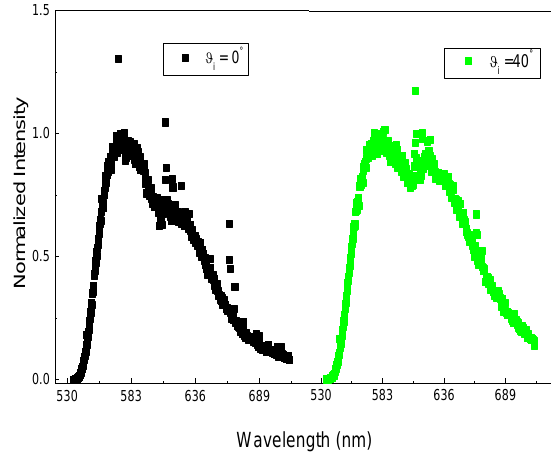
Figure 6. DNA-Cy3 fluorescence of the inverse opal obtained using an Ar + line (514.5 nm) and collecting the emission at 0° and 40° detection angles.